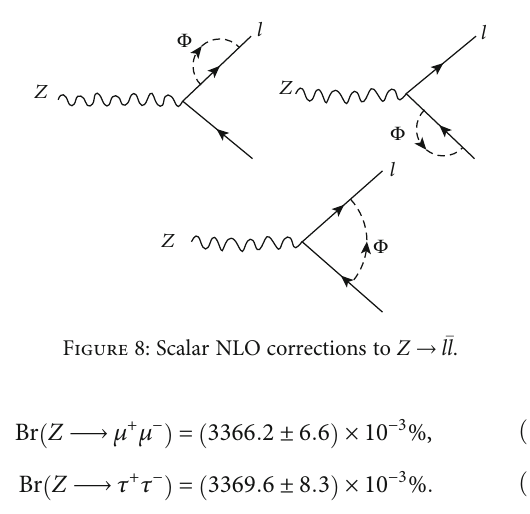
Figure 8: Scalar NLO corrections to Z → l (cid:1) l